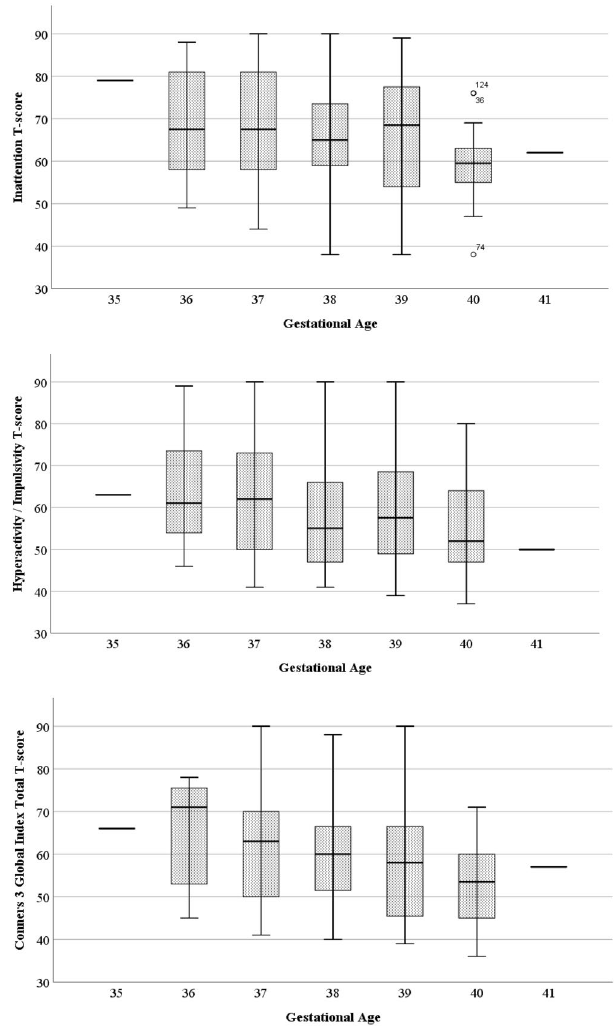
Figure 2. Simple box plot representing the distribution of ADHD outcomes in relation to gestational age in the 105 participants with Down